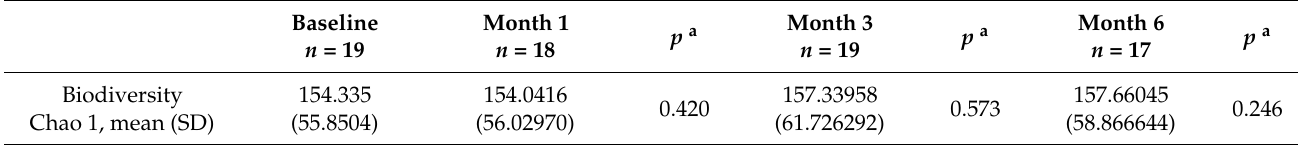
Table 2. Biodiversity and relative abundance of the gut microbiota bacteria by phylum, family, and genus during the treatment with DMF. The α biodiversity is expressed as the Chao 1 index. We reported all the analyzed phyla and the families and genera with significant modification in relative abundance during DMF treatment compared to baseline values. The taxa that increased at any time point during DMF treatment are shown in green and those that reduced in orange.